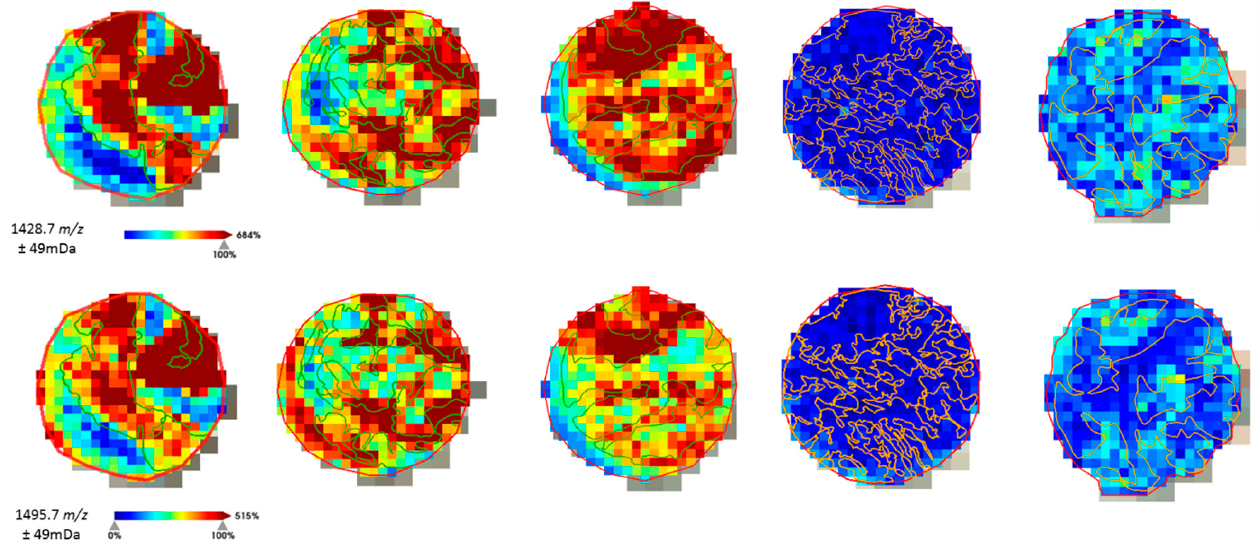
Figure 2. Example of the on-tissue distribution of a few molecular features obtained by ROC-AUC calculation. Histological annotation of the tumor regions (TNBC in green, non-TNBC in orange) could be correlated with the distribution intensity of the peptide fragments selected for TNBC.